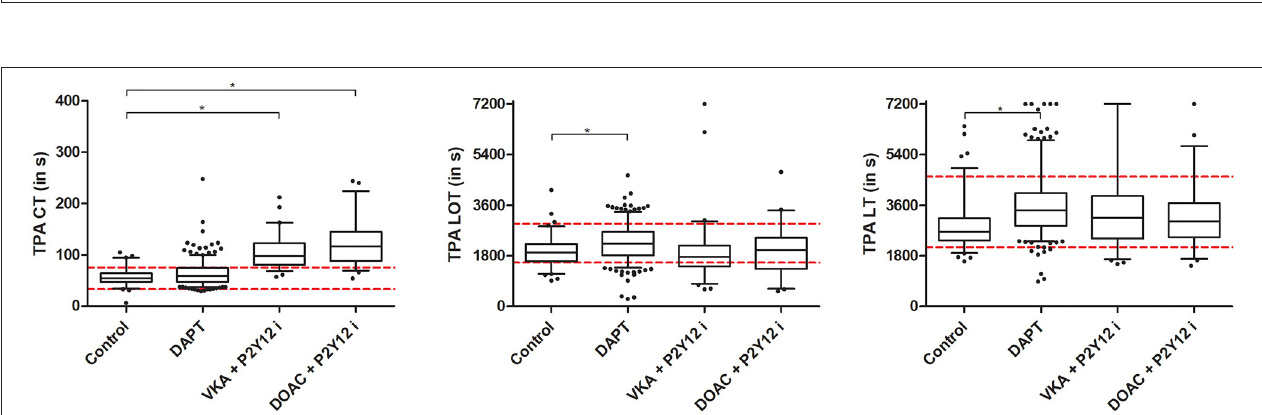
FIGURE 2 | EXTEM (A–C) , INTEM (D–F) and FIBTEM (G,H) results for clotting time (CT; A,D,G ), clot formation time (CFT; B,E ) and maximum clot firmness (MCF; C,F,H ). Presented are median, IQR and 5–95 percentile whiskers. Dashed lines illustrate reference ranges according to the manufacturer. Significant differences ( p < 0.008) compared to the control group are reported with an asterisk.